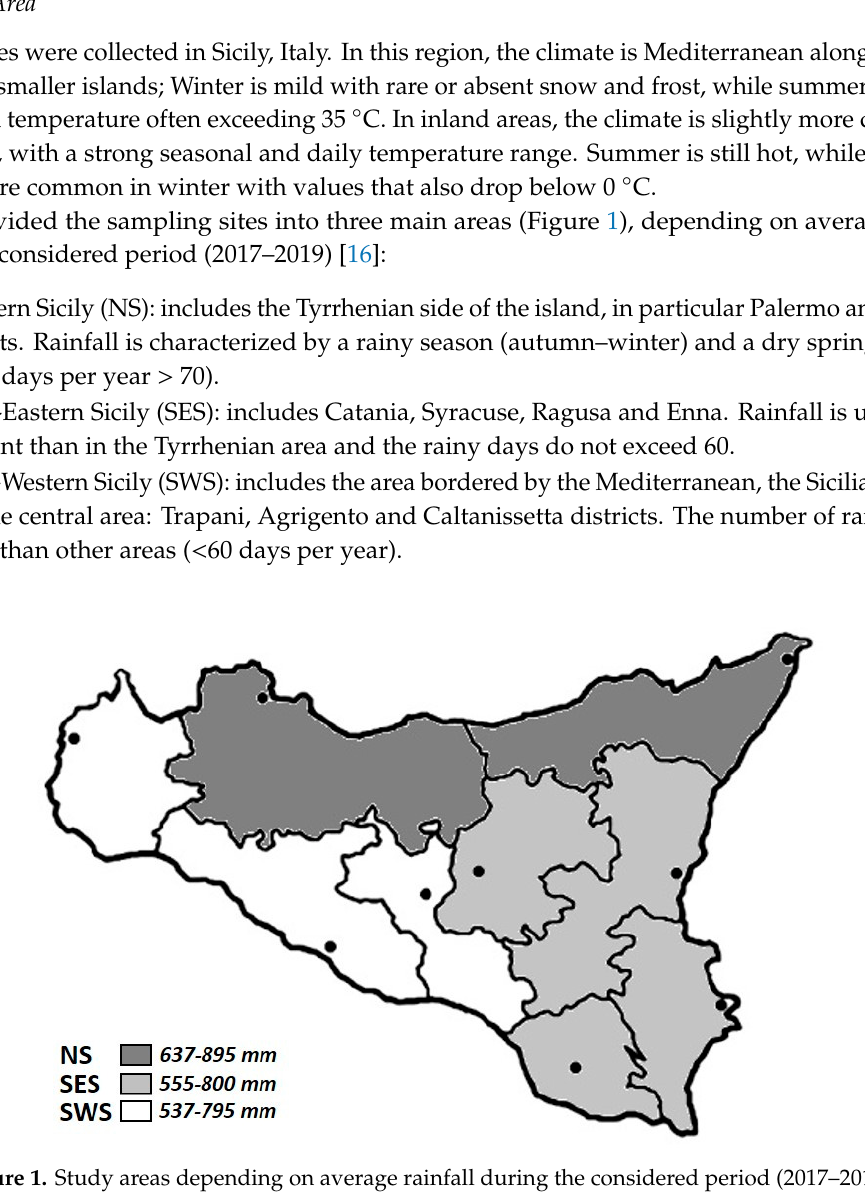
Figure 1. Study areas depending on average rainfall during the considered period (2017–2019).